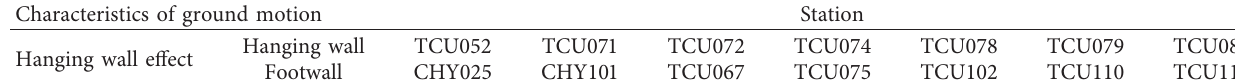
Figure 3: The meshed SSI model with soil boundary 20 times of the structural lateral dimension. Table 3: The selected accelerations of the hanging wall and footwall.